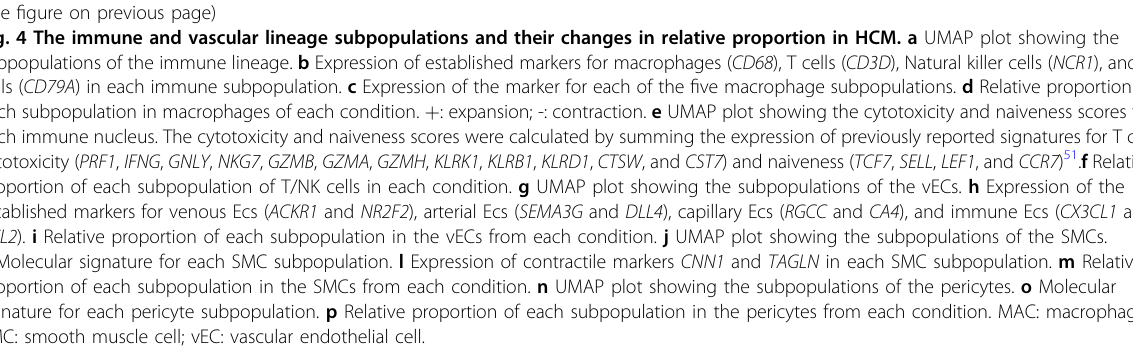
Fig. S13. Notably, energy metabolism and immune response-related pathways were upregulated in all three cell types, as they were in cardiomyocytes and fi broblasts.